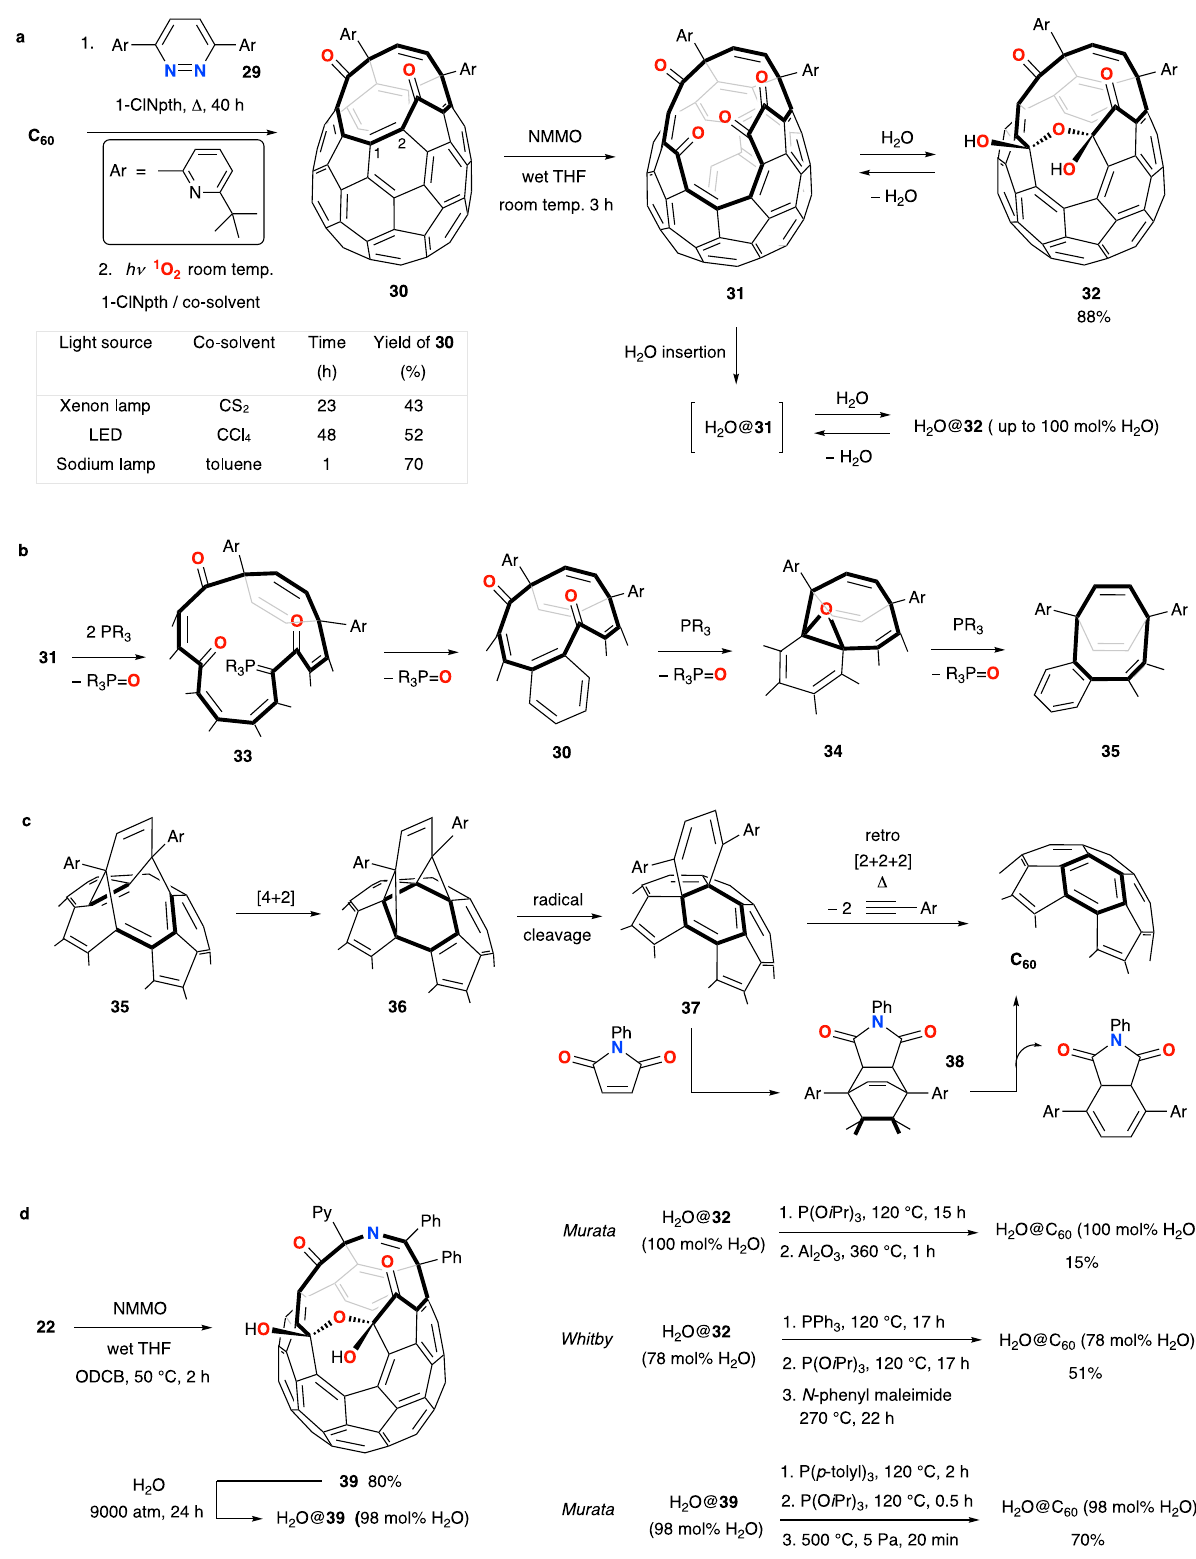
Fig. 5 Synthesis of H 2 O@C 60 . a Open-cage fullerene 31 has a 16-membered ori fi ce and is the substrate for encapsulation of H 2 O. Encapsulation occurs by in situ dehydration of 32 , see the main text for detail. b Double reductive coupling of carbonyl groups on the 16-membered tetraketone cage-opening. Only the ori fi ce atoms are shown. c Final cage-closure. d Synthesis of H 2 O@C 60 . 1-chloronaphthalene (1-ClNpth), N -methylmorpholine N -oxide (NMMO), 2-pyridyl (Py), o -dichlorobenzene